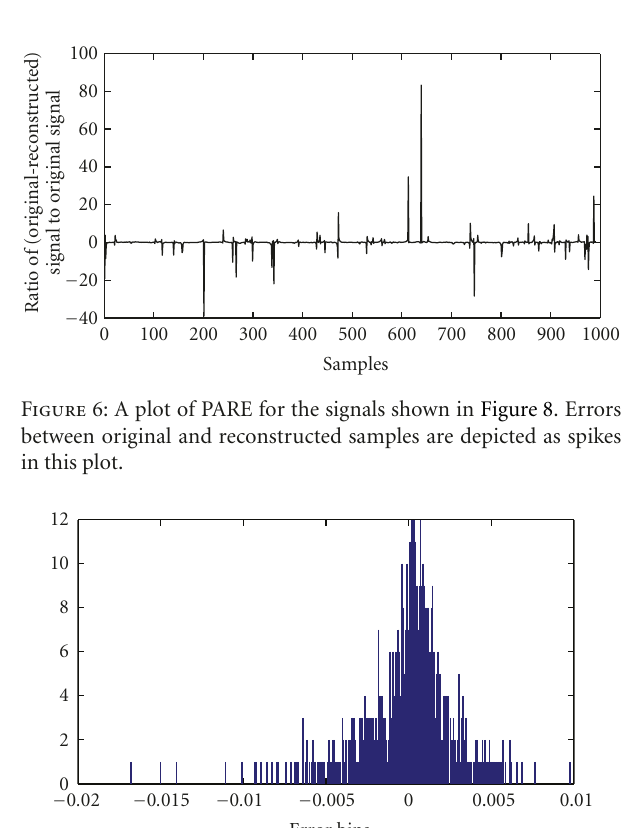
Figure 5: The FRI reconstruction block diagram for EEG signals.